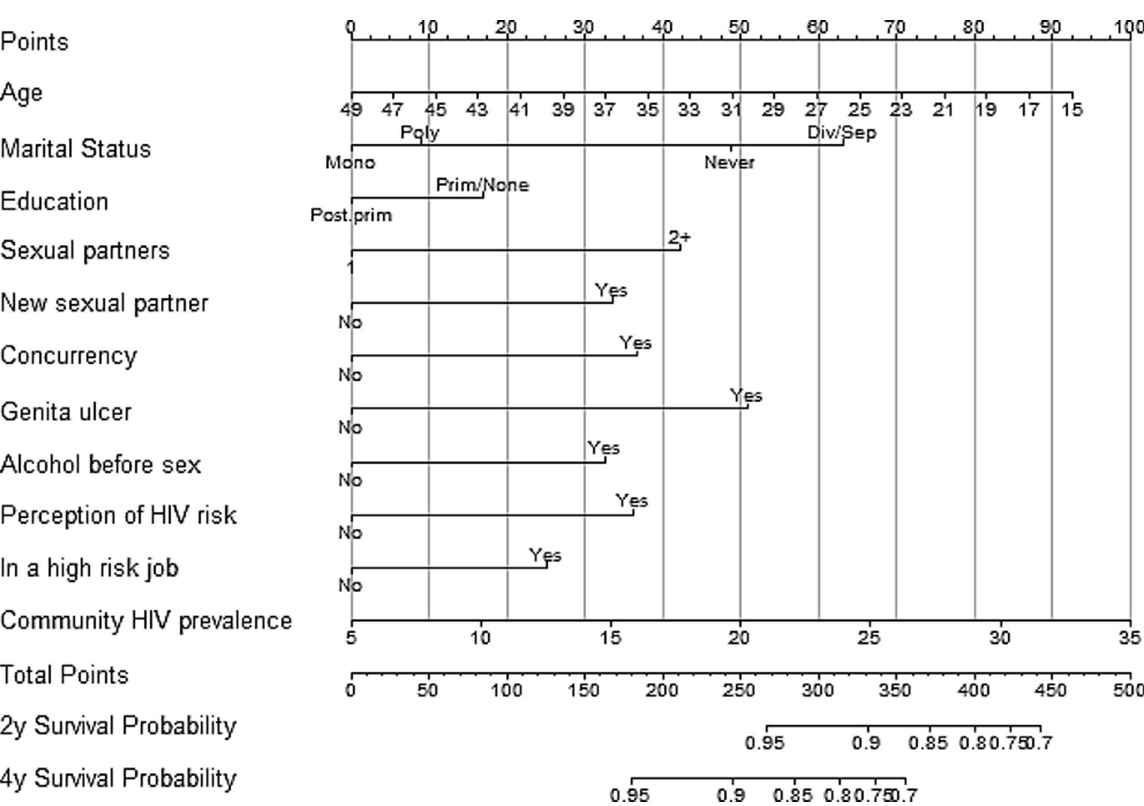
Men Women Nomogram Score Threshold range Upper quintile . 179 46.7 Upper two quintiles . 164 Upper quartile Upper third . 169 Upper